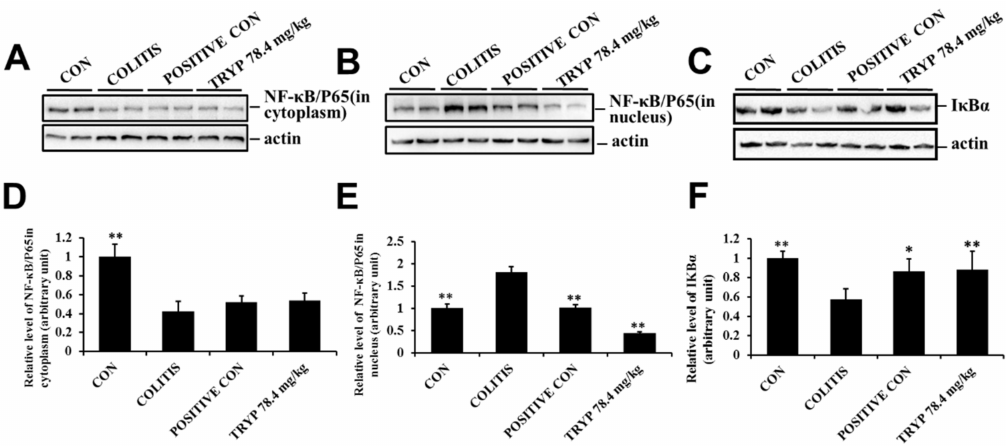
Figure 7. Effects of TRYP on the protein levels of NF- κ Bp65 and I κ B α . ( A ) Results of TRYP with concentration of 78.4 mg/kg on the protein level of NF- κ Bp65 in cytoplasm; ( B ) The protein levels of NF- κ Bp65 in nucleus; ( C ) Effects of TRYP on the protein levels of I κ B α ; ( D – F ) The column charts represented the relative protein level of NF- κ Bp65 and I κ B α . Error bars represented means ± SEM of n = 3, * p < 0.05 and ** p < 0.01 compared with colitis.